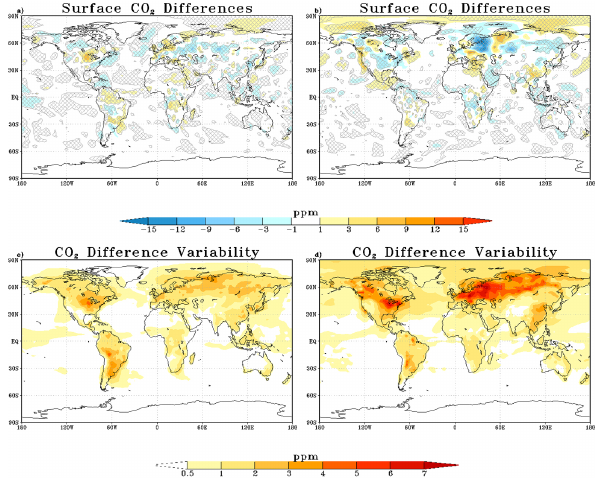
Figure 20. Surface CO 2 differences (Method 3 minus Method 2) for (a) 1:30Z 1 July 2009 and (b) 1:30Z 1 January 2010. Hatch marks represent significance at the 90% level using the Student’s t test. Crosshatch marks represent significance at the 95% level. Standard deviation of surface CO 2 differences (Method 3 minus Method 2) for (c) July 2009 and (d) January